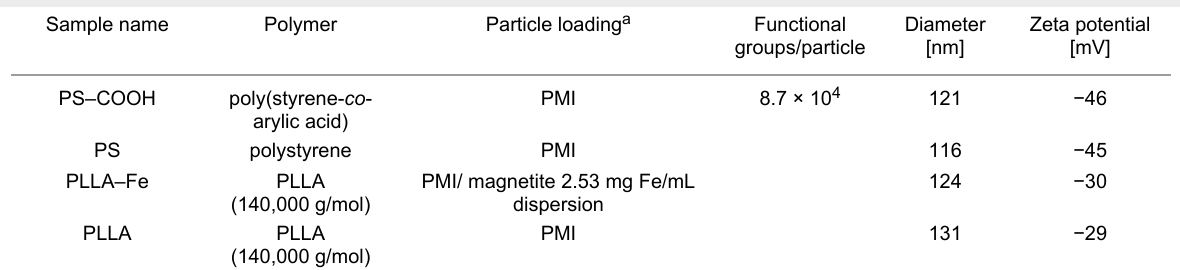
Table 1: Characterization of the nanoparticles.